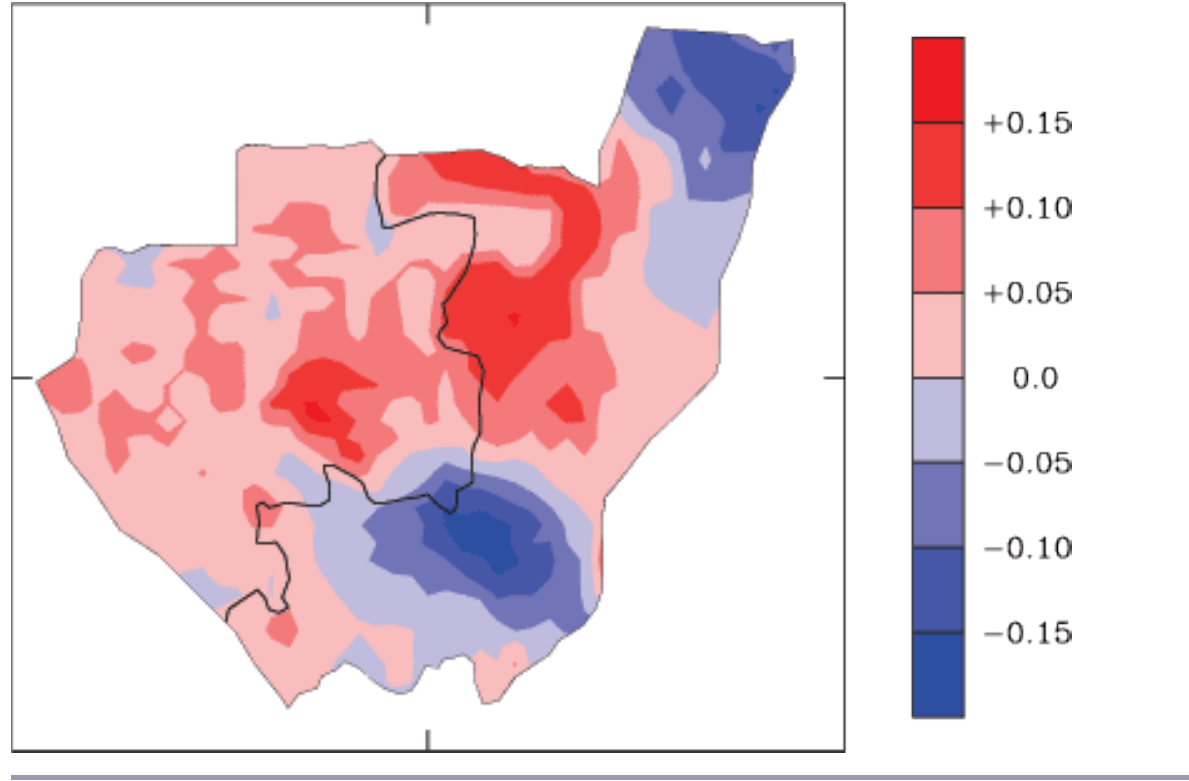
Fig. 5 . Simulated monthly averaged near-surface air temperature differences (K) between control and deforestation scenarios for October 2001 in Gabon and the Republic of